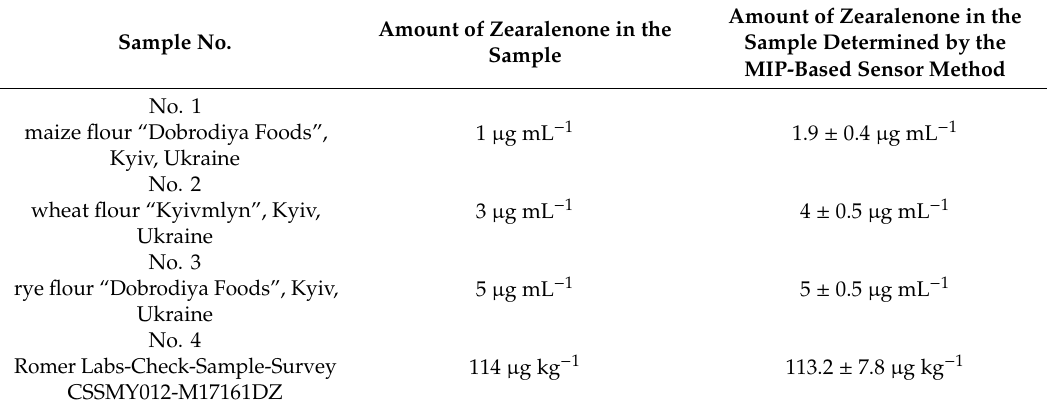
Table 5. Results of zearalenone detection in real samples of cereals using MIP membrane-based sensor *. Amount of Zearalenone in the Sample No.